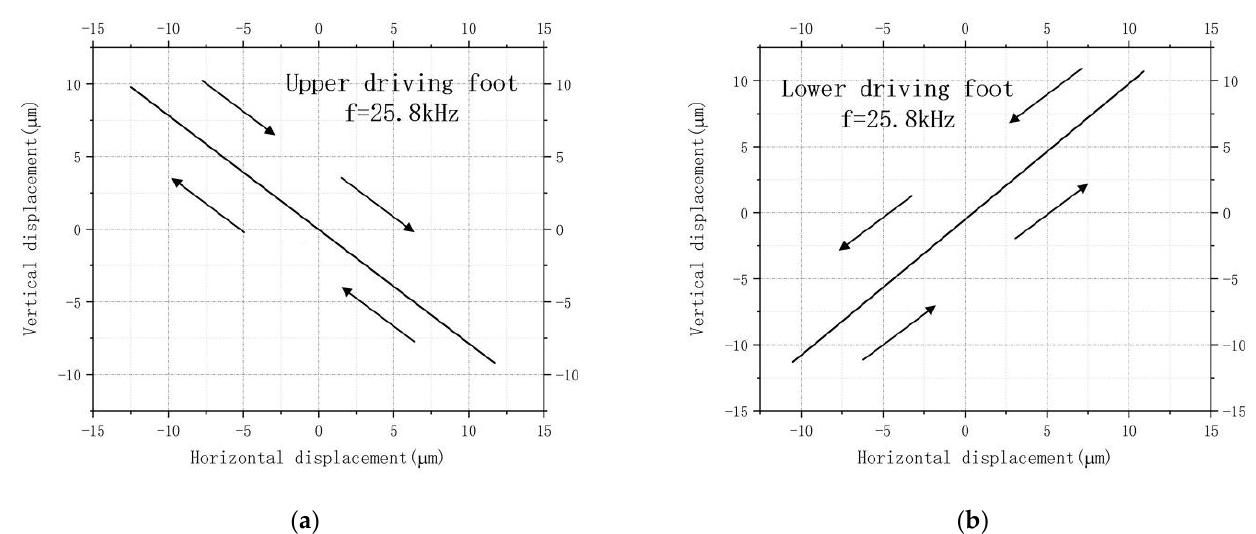
Figure 8. Trajectories of the driving feet: ( a ) the upper driving foot; ( b ) the lower driving